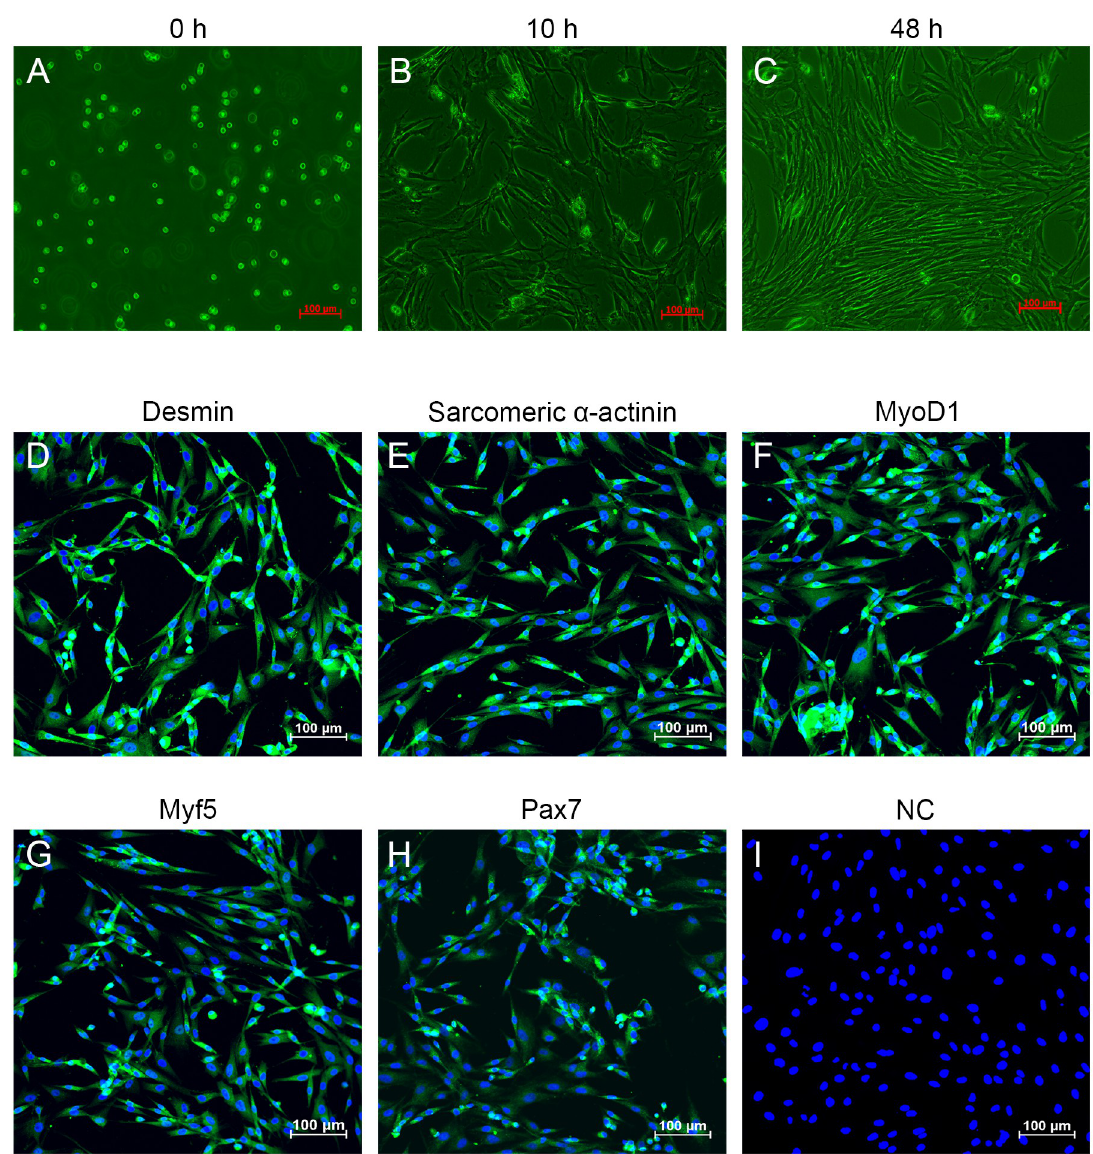
Fig 1. The isolation and identification of muscle-derived stem cells (MDSCs). (A) MDSCs were isolated from the leg muscle of Wistar rats (0 h). (B) MDSCs were induced for 10 h. (C) MDSCs were induced for 48 h. (D-H) The MDSCs markers, including desmin, sarcomeric α -actinin, MyoD1, Myf5, and Pax7, were detected using immunofluorescence staining, respectively. (I) MDSCs stained with DAPI were considered as the negative control (NC). Scale bar is 100 μ